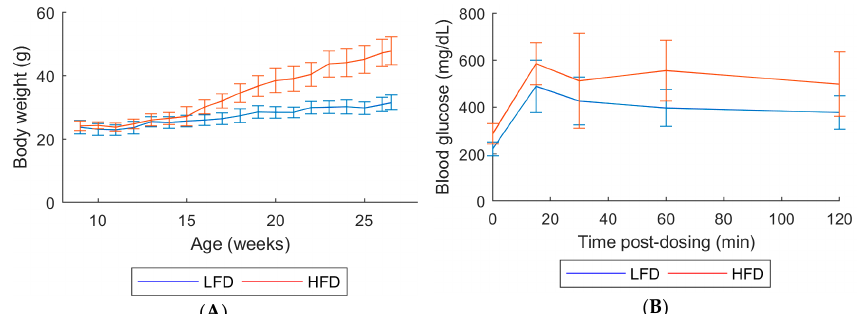
Figure 1. ( A ) Body weight measured weekly. ( B ) Glucose tolerance test at age 18 weeks. Animals in each group: 10 males. Error bars indicate the standard deviation of biological replicates ( n = 10). Abbreviations: LFD, low-fat diet; HFD, High-fat diet.